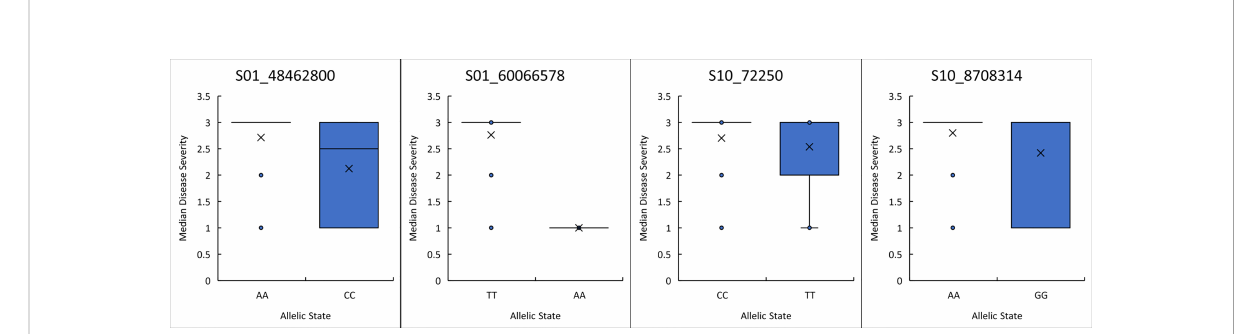
FIGURE 2 Boxplot of anthracnose resistance scores for the allelic state of each of the peak SNPs identi fi ed on Pv01 and Pv10. The student ’ s t-test indicated the allelic state means were signi fi cantly different for S01_48462800, S01_60066578, and S10_8708314 with probabilities of 0.01, 0.00 and 0.00,